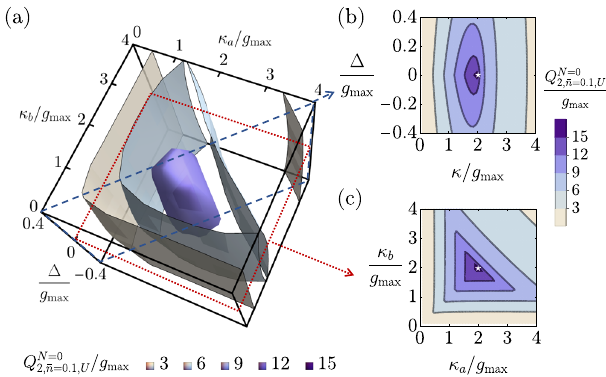
Fig. 8 | Diagrams forthenumericalsearch oftheoptimized 0-stagetransducer parameters that can attain the highest possible continuous-time two-way thermal-loss quantum capacity upper bound with a mean thermal photon -- n = 0 : 1. a Contour plot of the continuous-time two-way thermal-loss number capacity upper bound for N =0, Q N =0 2, (cid:2) n =0 : 1, U , in the parameter space of κ a , κ b , and − Δ Δ ≡ Δ a b . b Asliceintheparameterspacewithsymmetricexternalcouplingrates κ κ . The white star represents the location of the maximally fl at parameters. κ a = b = c A slicein theparameter space under the resonant condition Δ =0.The white star represents the location of the maximally fl at